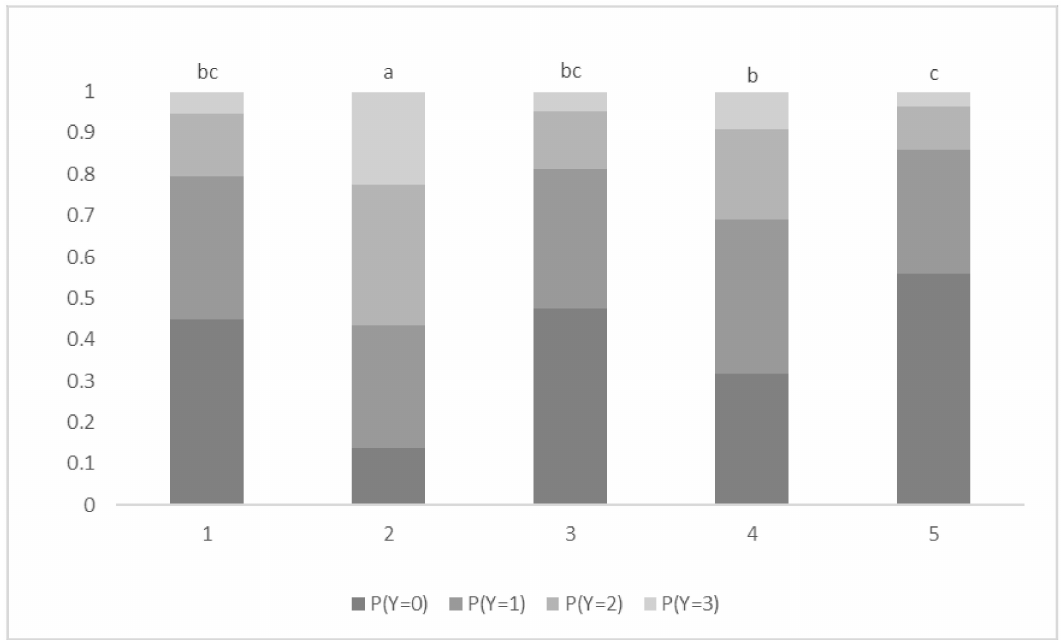
Figure 2. Probability (P) of all calves displaying behavioural response scores (Y; 0 = zero movement, 1 = mild movement, 2 = moderate movement, 3 = severe movement) to sham castration or castration at different stages of the procedure. Stage: 1 = excision of scrotum; 2 = extrusion of right testis and spermatic cord; 3 = severing of right spermatic cord; 4 = extrusion of left testis and spermatic cord; and 5 = severing of left spermatic cord. a,b,c Stages with different superscripts differ significantly at p ≤ 0.05. A significant effect was found ( p <